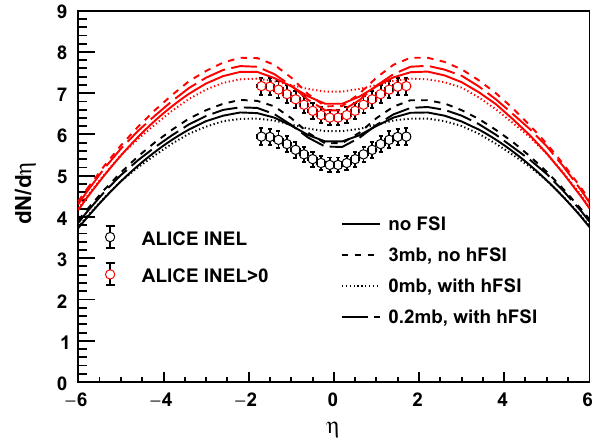
Fig. 5 Time evolutions of energy (solid) and number (dashed) density for the parton system generated in pp collisions at b = 0 fm with parton rescatteringcrosssection0.2mb(black)and3mb(red)fromtheoverlap function weighting method